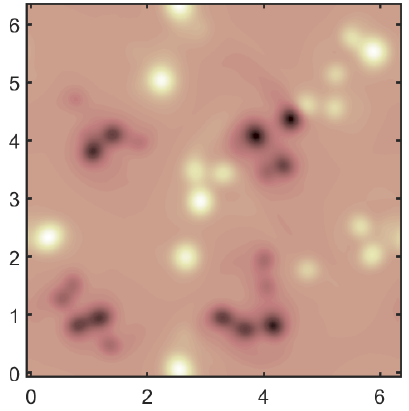
Figure 2. Filtered vorticity field with filter width ∆ = 0.4 at t ∗ = 4.55.